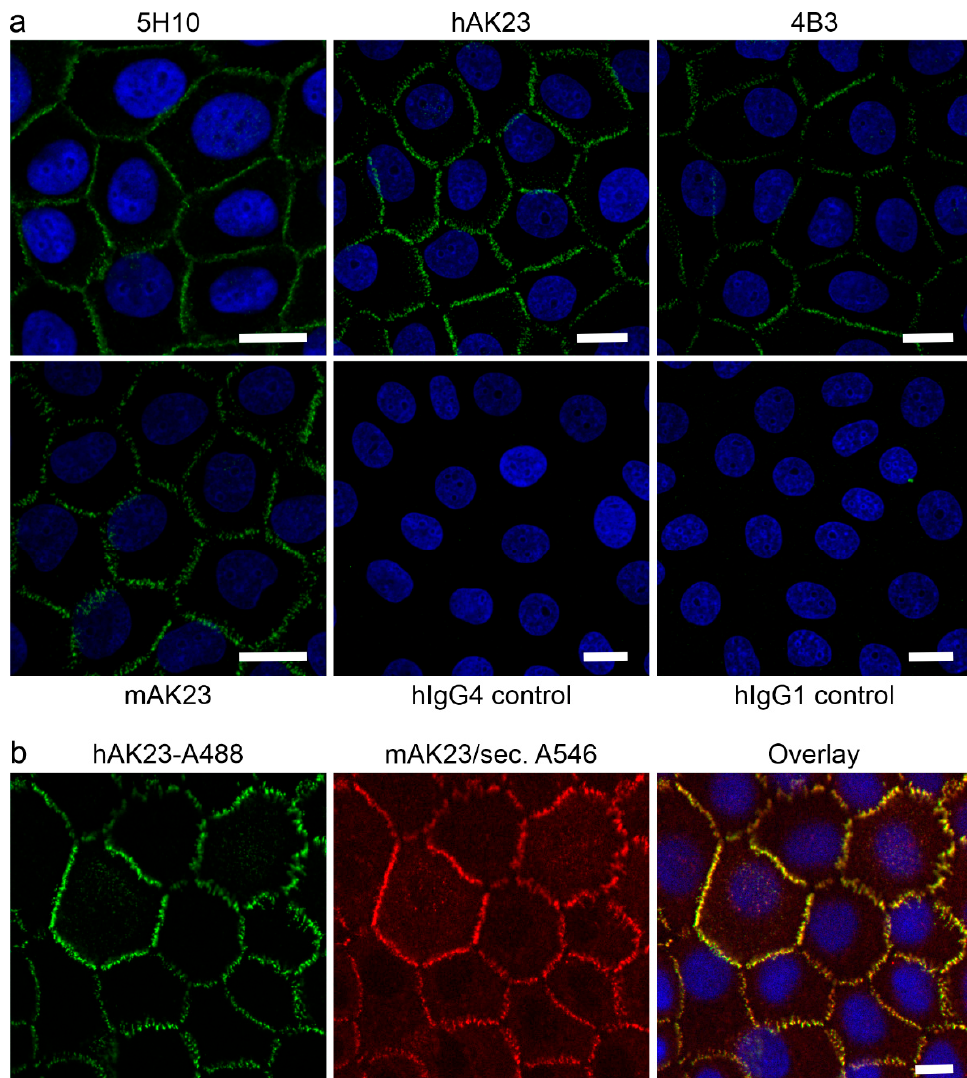
Figure 1. Staining pattern of Dsg3 in human hTert keratinocytes with the hAK23 and 4B3 antibodies is highly similar to mAK23 and 5H10 antibodies. Human hTert keratinocytes were cultured on coverslips in KGM2 medium with 0.05 mM CaCl 2 for at least three days, and then switched to KGM with 2 mM CaCl 2 for 24 h. After fixation with methanol, the cells were stained with recombinant anti-Dsg3 antibodies hAK23 or 4B3, as indicated. Staining with the anti-Dsg3 5H10 antibody, mAK23 or isotype-matched human control IgGs (hIgG) were included as controls. ( a ) Post-fixation staining with the indicated antibodies. Fluorochrome-coupled secondary antibodies (anti-mouse or anti-human Alexa Fluor 488, green) were used for the detection of the bound primary antibodies. ( b ) Double staining with Alexa Fluor 488-coupled hAK23 (16 µg/mL, green) and mAK23 (8 µg/mL) detected with a secondary antibody coupled with Alexa Fluor 546 (red). The coverslips were mounted using a mounting medium with DAPI (blue). Representative images from one out of three independent experiments are shown. Scale bar: 20 µm.